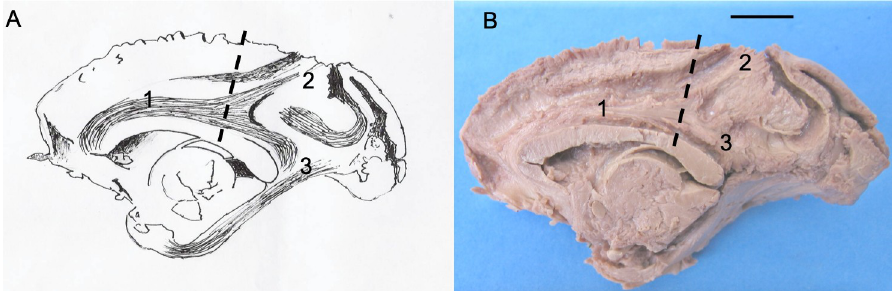
Fig 3. Schematic drawing (A) and photograph (B) of the right hemisphere of a specimen of Sapajus sp. indicating the cingulate fascicle and the longitudinal fascicle in the same bundle [1], separating approximately at level of the central sulcus [dotted line], into an individualized longitudinal fascicle [2] and an individualized cingulate fascicle [3]. [4] Corpus callosum; [5] Fornix; [6] Thalamus; [7] Frontal pole; [8] Occipital pole. Specimen: Adult male. Bar = 1 cm.